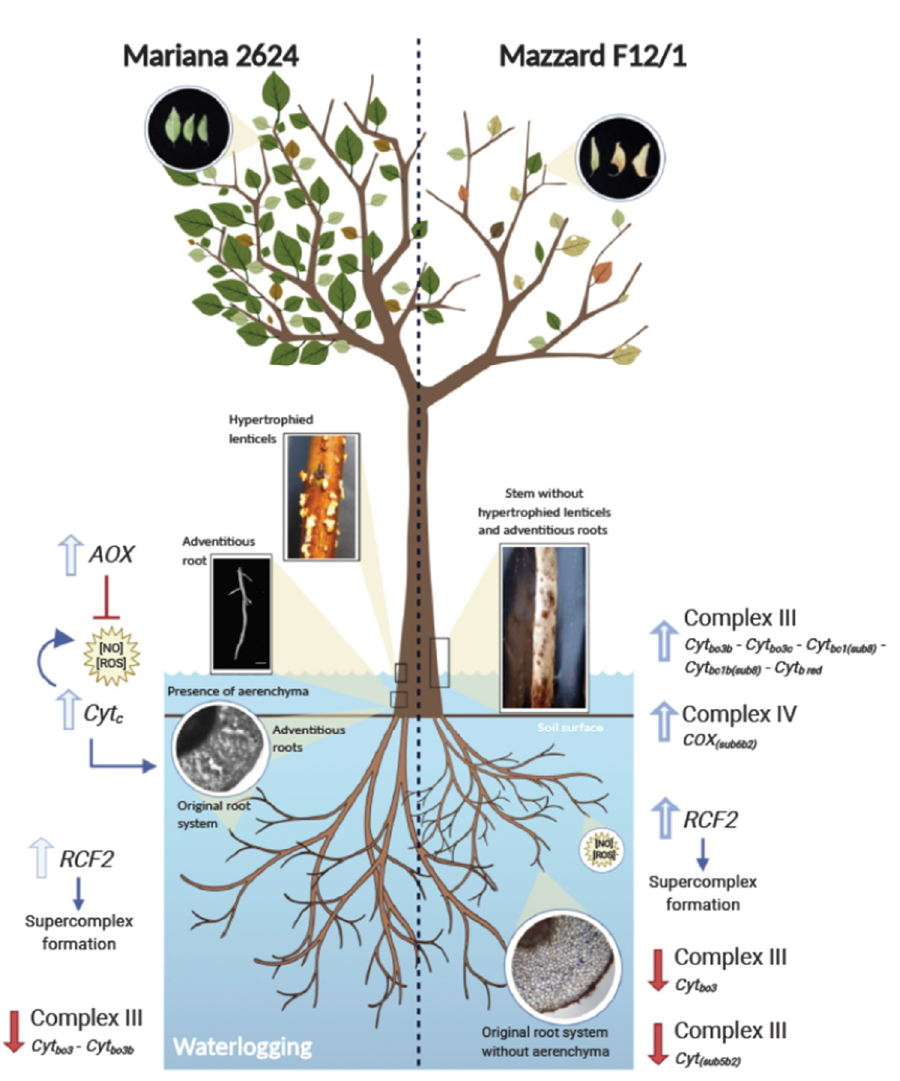
Figure 3. Schematic overview of principal mETC-expressing genes and morpho-anatomical changes in Prunus rootstocks under root hypoxia. The figure summarizes the effect of AOX and Cyt c on NO and ROS generation. Regarding ROS, the early induction of AOX (6 h) and the late induction of Cyt c (24 and 72 h) would lead to a regulation of ROS accumulation in a temporally non-exclusive way in the root-hypoxia-tolerant Prunus rootstock (‘Mariana M2624’). Thus, at the beginning of stress by O 2 deficiency, this genotype would be preventing the accumulation of ROS in roots, but as stress progresses, in the context of apoptosis, the elevation of ROS levels has been associated with the activity of Cyt c [171,172]. The generation of aerenchyma mediated by apoptosis present in the original root system, and the generation of adventitious roots with aerenchyma and hypertrophied lenticels, are characteristic features of ‘Mariana M2624’. These traits are completely absent in the root-hypoxia-sensitive Prunus rootstock (‘Mazzard F12 / 1’). The generation of air-filled spaces results in an avoidance strategy in relation to O 2 deprivation, which is associated with the maintenance of an adequate metabolism and energy supply at the whole plant level. The blue and red arrows represent the over- and down-expression of genes related to mETC. AOX , alternative oxidase; Cyt c , Cytochrome